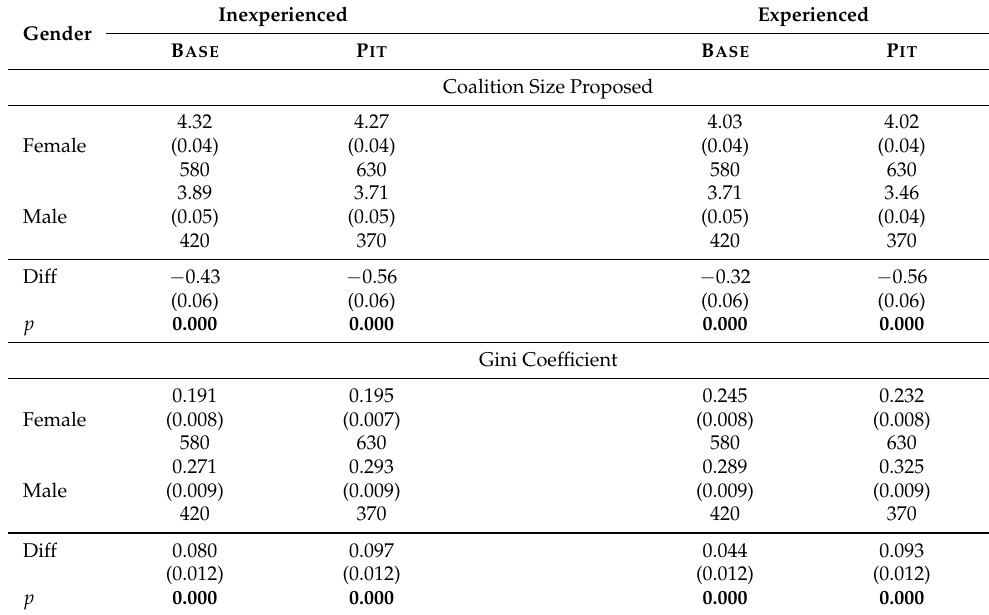
Table A7. Proposed Coalition Size, Gini, and Share of Equal Distributions Proposed by Experience, Treatment, and